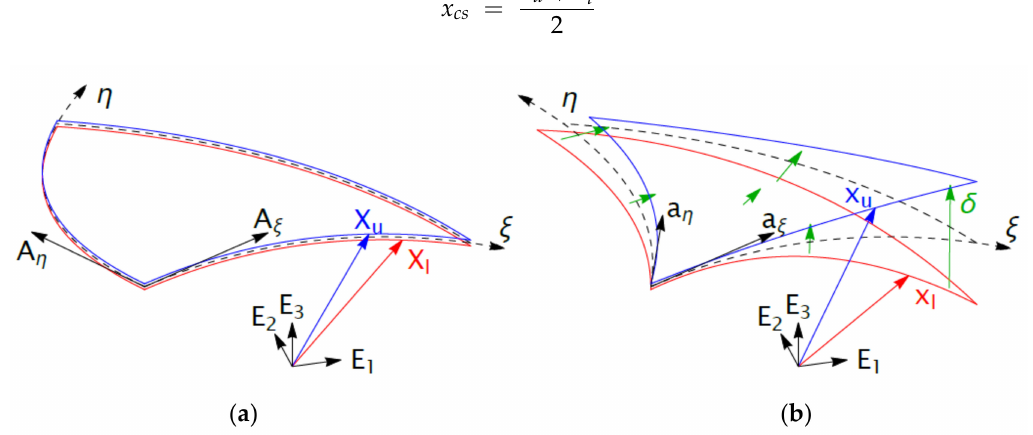
Figure 3. Separation of a joining zone; initial configuration ( a ) and current configuration ( b )